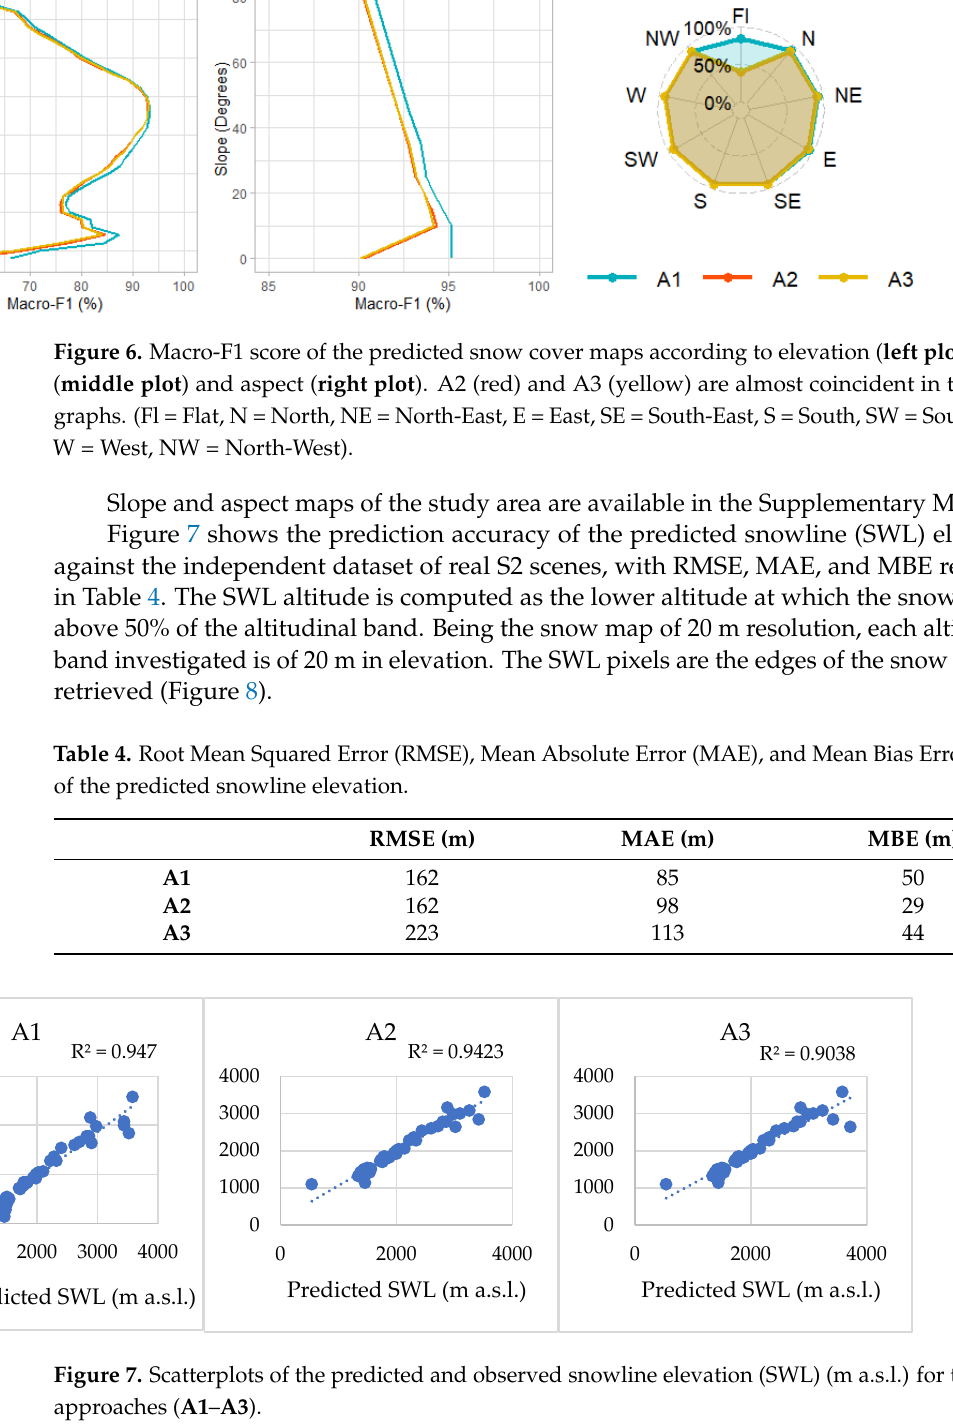
Figure 8. Example of the snowline (SWL) elevation and pixels predicted against the real S2 scene acquired on 24 June 2016. Top left : natural color S2 with close-up area. A1 – A3 : close-up with real S2 SCE map in background and SWL pixels and elevation computed, respectively, with A1, A2, and A3 approaches. In 25% of times (11 times out of 44 observations), the snowline is predicted with an elevation error of 0 m. However, the results show that there are outliers in the time series, up to an estimation error of 680 m. This suggests that the overall time series is reliable, but the single predicted scenes are not always, and it would be useful to integrate a prediction check based on contiguous days into the algorithm to eliminate these outliers.